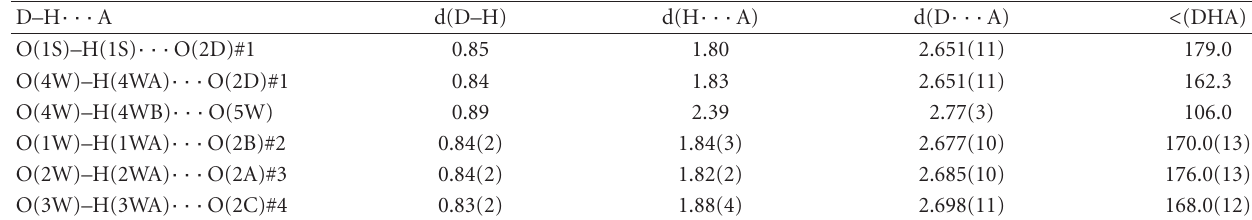
Table 3: Hydrogen bonds for [Zn(L–H) 2 (H 2 O) 2 ][Zn(L–H) 2 (H 2 O)(MeOH)]H 2 O [ ˚A and ◦